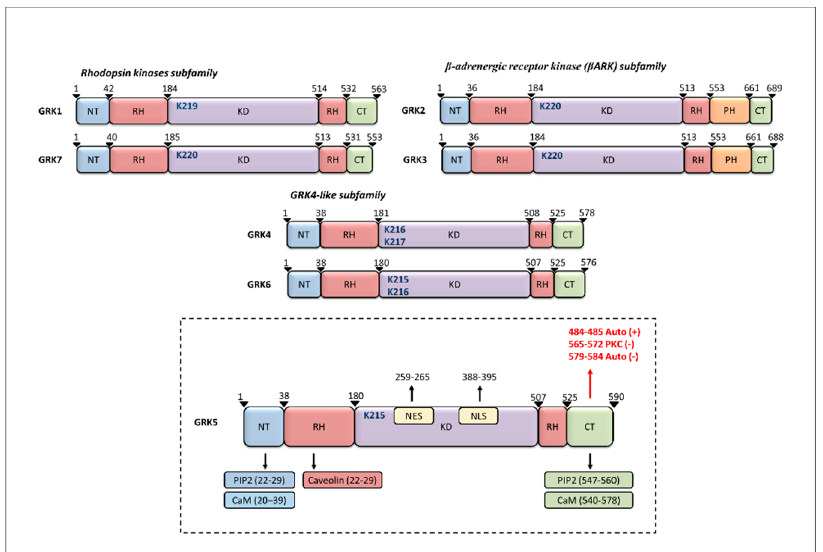
Figure 1. Schematic representation of G protein-coupled receptor kinases (GRKs) structure. All GRKs share a common structure, comprising a N terminal (NT) region, followed by an RH domain, which includes the kinase domain (KD). Catalytic activity is dependent on lysine residues (in blue) that are specific for each isoform. The C terminal (CT) region is variable among the different subfamilies. GRK5 structure includes indication of phosphatidylinositol 4,5-bisphosphate (PIP2), Calmodulin (CaM), and caveolin binding sites. The residues of GRK5 that are autophosphorylated or phosphorylated by protein kinase C (PKC) are indicated in red.